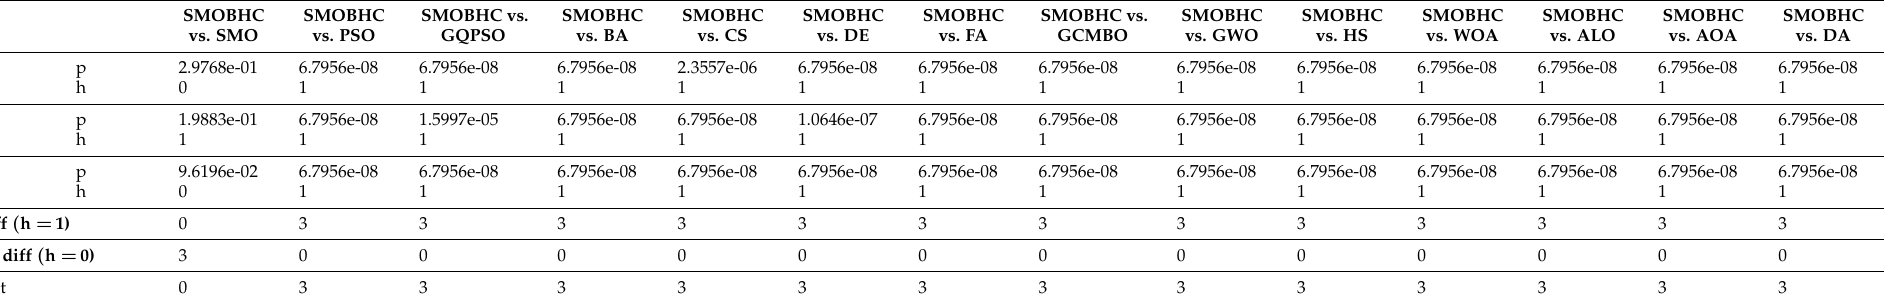
Table 6. Summarised Wilcoxon rank-sum comparisons between the SMOBHC algorithm as a reference and fourteen experimented algorithms for the second battlefield composed of thirty